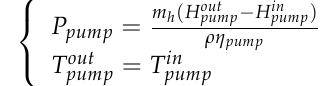
stand for the into and out of